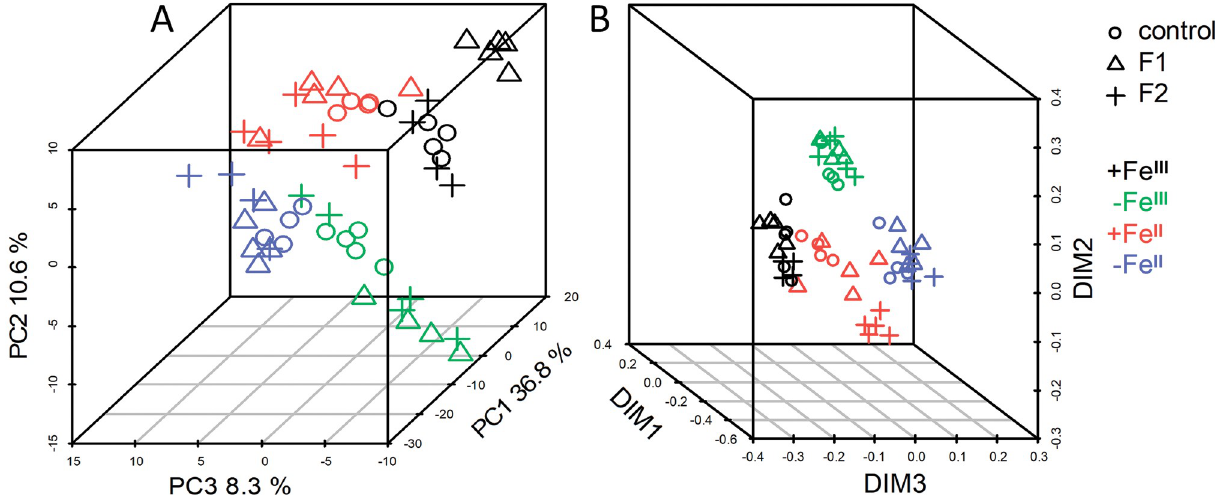
Fig 2. Unsupervised dimension reduction. Representing metabolite profiles of cucumber leaves grown hydroponically in a nutrient solution, either with (+Fe II and +Fe III ) or in Fe-free ( − Fe II and − Fe III ) nutrient solution, with or without the supply of 0 (F0), 1 (F1) and 2 (F2) mg L -1 fullerenol for 10 days in low dimensional space. Data are normalised to the median of observation, log-transformed and standardised. A—PCA score plot, %—the variance associated with the PC. B—representation of metabolite profiles in space obtained using MDS (multidimensional scaling) using Spearman distance (1 −